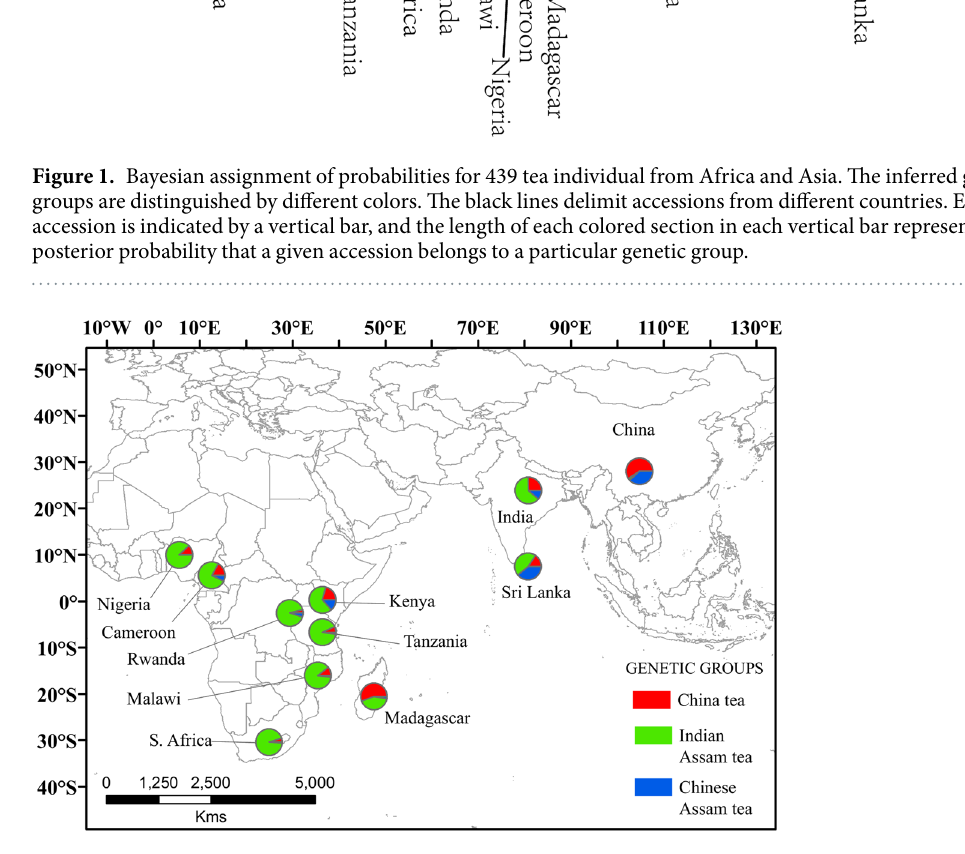
Figure 2. Geographic distribution of nSSR alleles. The colours correspond to the genetic clusters defined by STRUCTURE analysis at K = 3. The proportions of different groups in pie-charts are based on membership coefficients at K = 3. A shape file with genotype proportions in the different countries was generated in DIVA- GIS v7.5.0.0 (http://www.diva-gis.org/). The shape file was then used to generate the map in ArcGIS v10.2.2 (Environmental Systems Research Institute, Redlands, CA, USA)